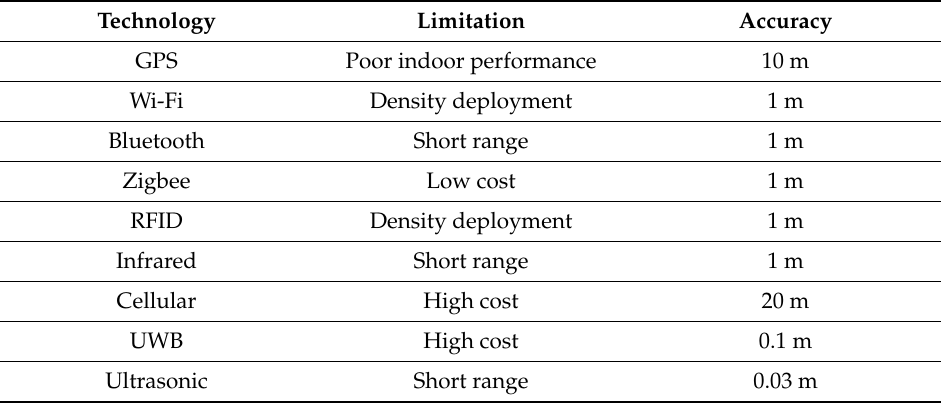
Table 1. Summary of localization